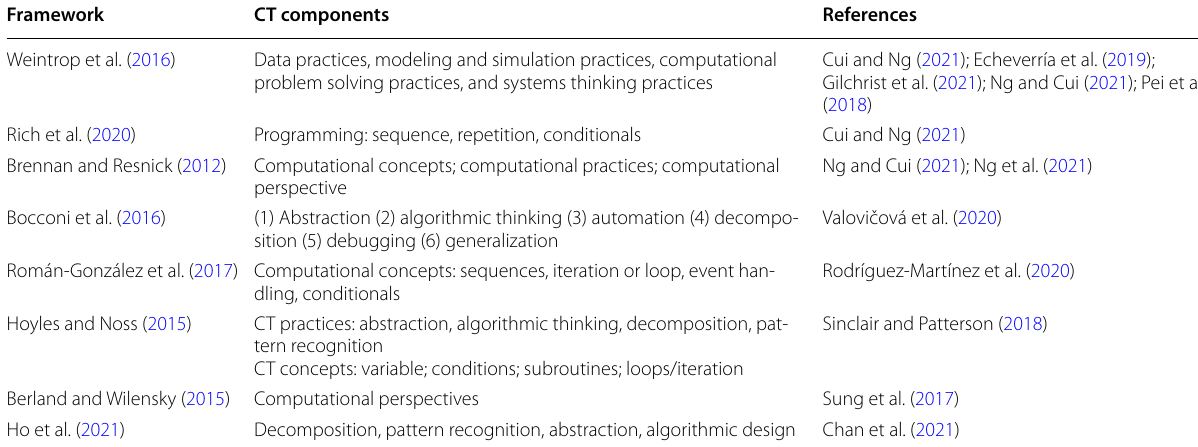
Table 3 Different frameworks of CT used in the reviewed articles Framework CT